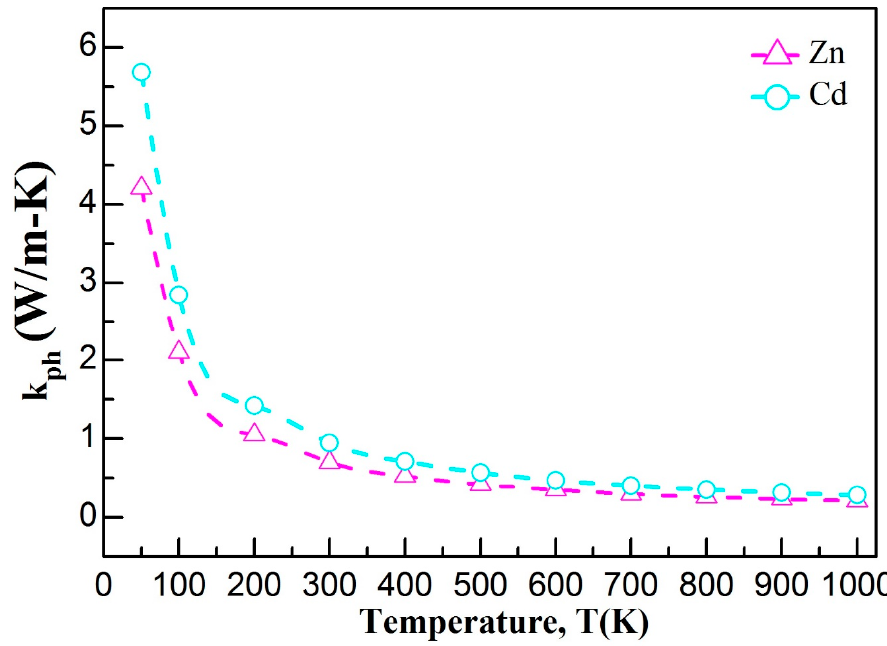
Figure 6. Temperature dependence of lattice thermal conductivity of RbNbCd and RbNbZn.